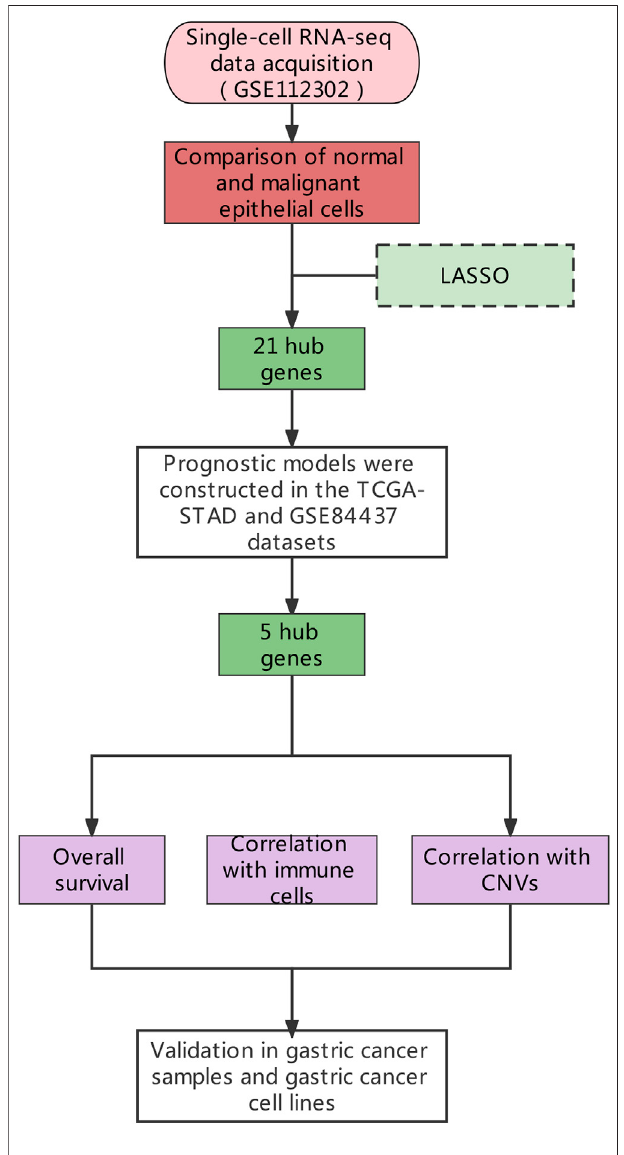
FIGURE 1 | The general research